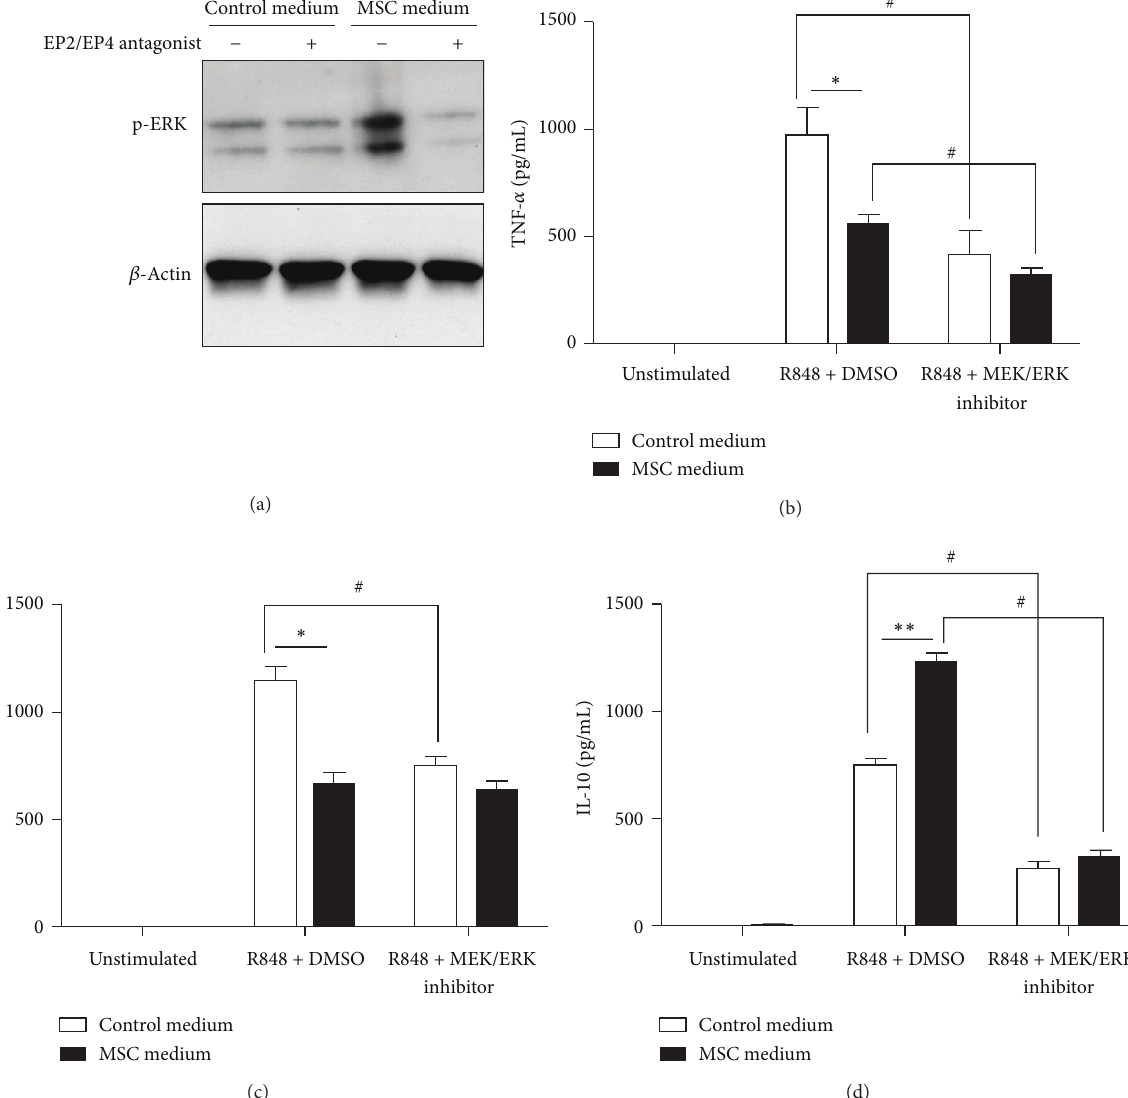
Figure 5: ERK signaling is partially responsible for the modulated expression of IL-10, but not that of TNF- 𝛼 or IL-6, in BMDMs preincubated inMSC-conditionedmediumfollowedbyR848stimulation.(a)BMDMswerepreincubatedinMSC-conditionedmediumorcontrolmedium with or without a cocktail consisting of an EP2 antagonist (AH6809, 10 𝜇 M) and an EP4 antagonist (GW 627368X, 10 𝜇 M). DMSO was used as a vehicle. After 1h, R848 (TLR7/8 ligand, 10 𝜇 g/mL) was added, and BMDMs were incubated for an additional 0.5 h. The p-ERK level was determined by immunoblotting. Beta-actin was used as a loading control. Results are representative of 3 independent experiments. (b–d) BMDMs were preincubated in MSC-conditioned medium or control medium with or without MEK/ERK inhibitor (U-0126, 10 𝜇 M). DMSO was used as the vehicle. After 1h, R848 (TLR7/8 ligand, 10 𝜇 g/mL) was added, and BMDMs were incubated for an additional 24 h. The levels of TNF- 𝛼 (a), IL-6 (c), and IL-10 (d) were determined using ELISA. ∗ 𝑃 < 0.05 and ∗∗ 𝑃 < 0.01 , compared to the control medium group. # 𝑃 < 0.05 , compared to the R848-stimulated cells (without MEK/ERK inhibitor). Data are expressed as the mean ± SEM. 𝑛 = 3 in each group. Results are representative of 3 independent